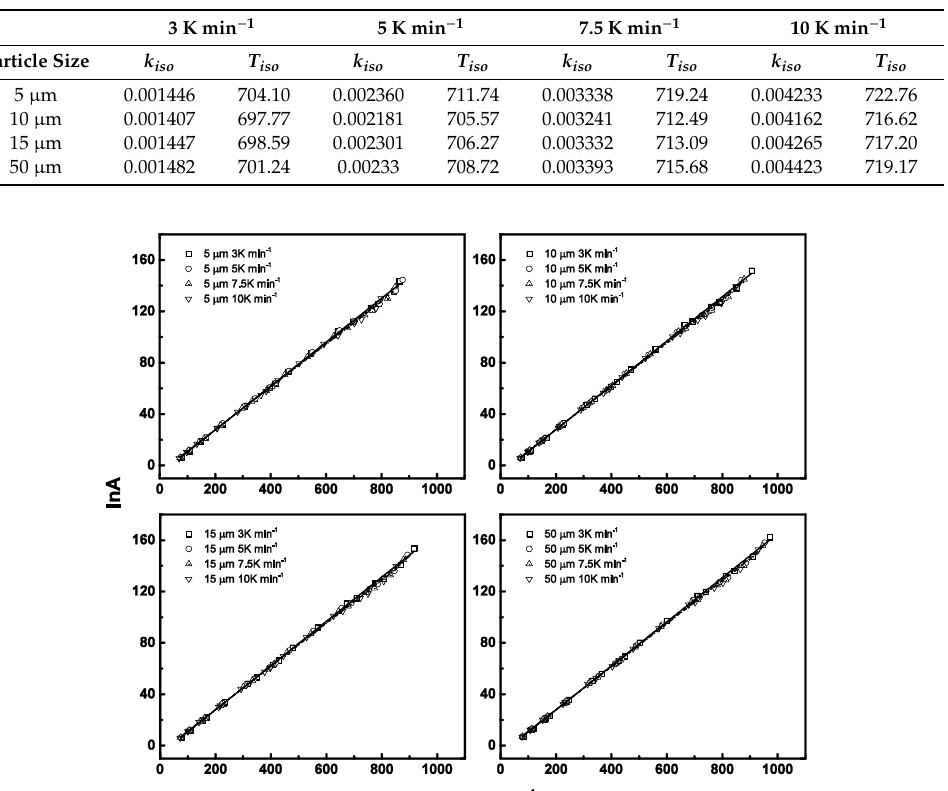
Figure 4. The isokinetic relationships (ln A vs. E a ) obtained during degradation process using Coats–Redfern method for different particle sizes and heating rates.